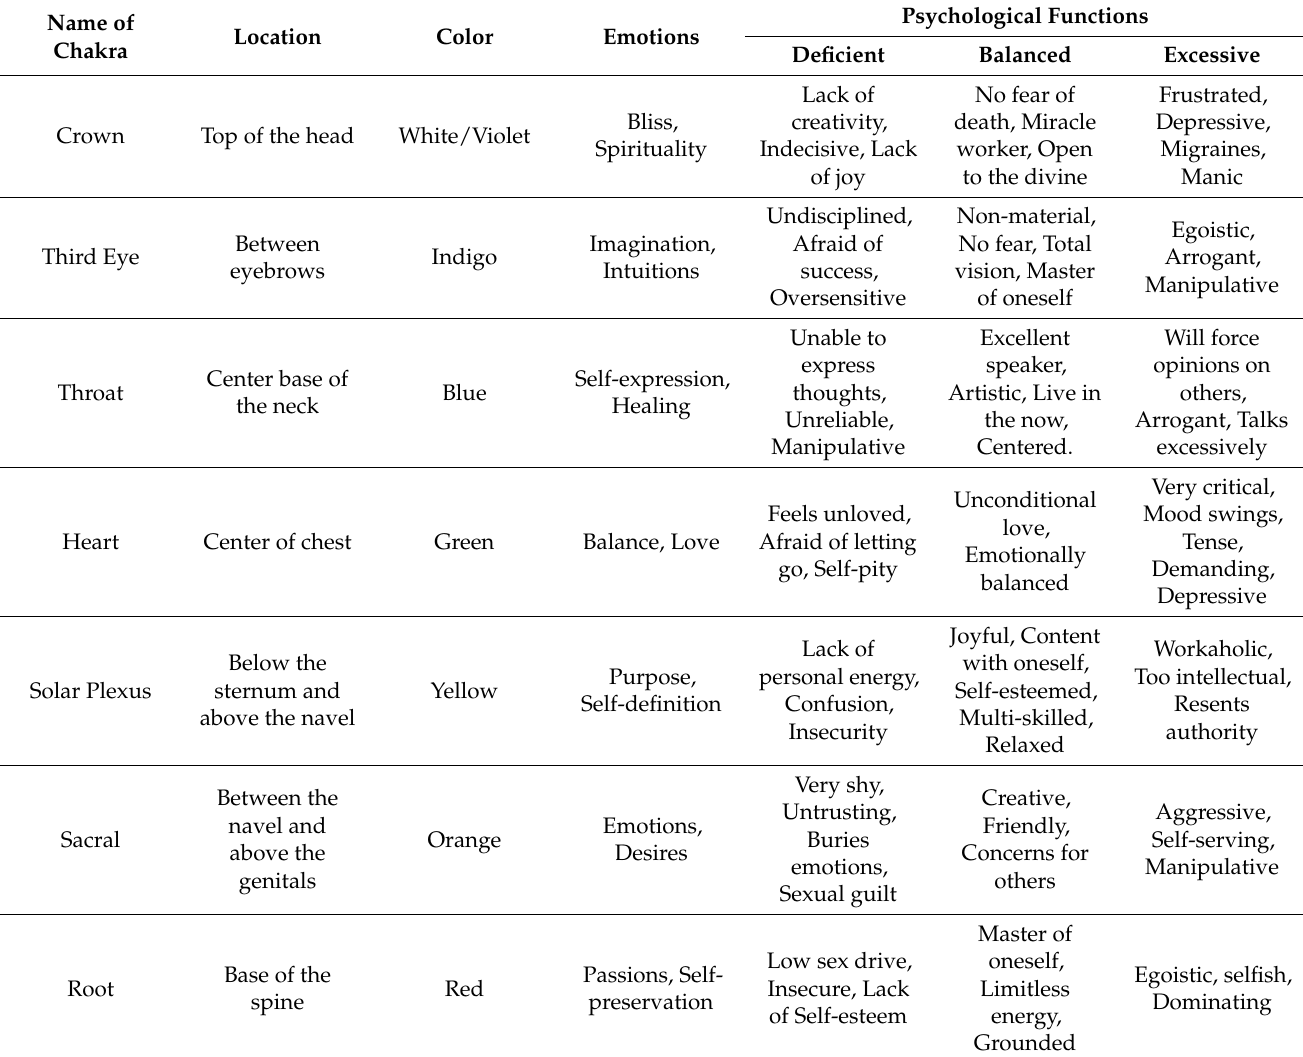
Table 1. Chakras and related psychological functioning effects